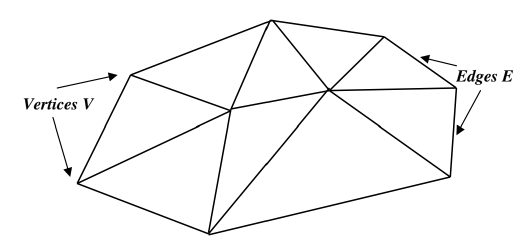
Figure 3. 9 vertices connected by Delaunay